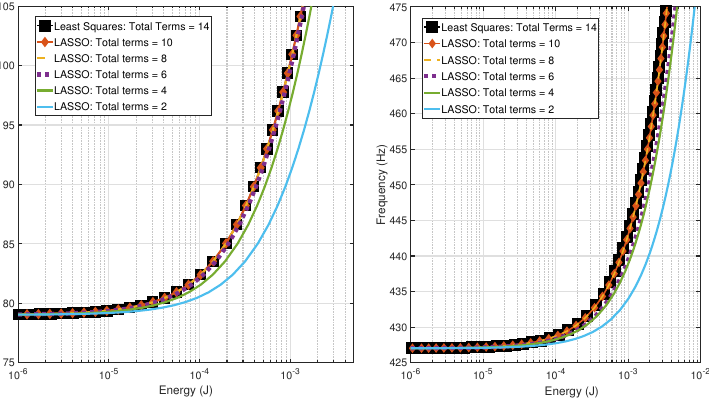
Figure 5. Frequency energy plot of the first (left) and third (right) nonlinear normal modes (NNMs) of the flat beam for ROMs created using least squares and using LASSO with various penalty terms.